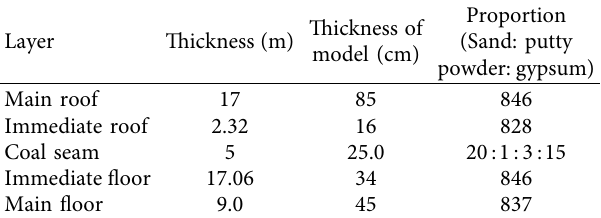
Table 1: The proportions of similar materials.